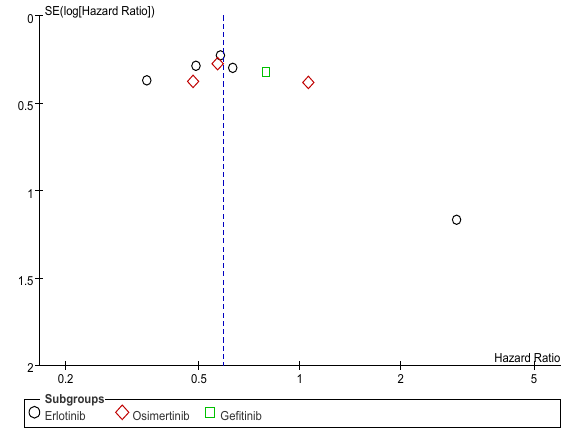
Figure A5. PFS comparisons among ever smoker stratified by regimen.